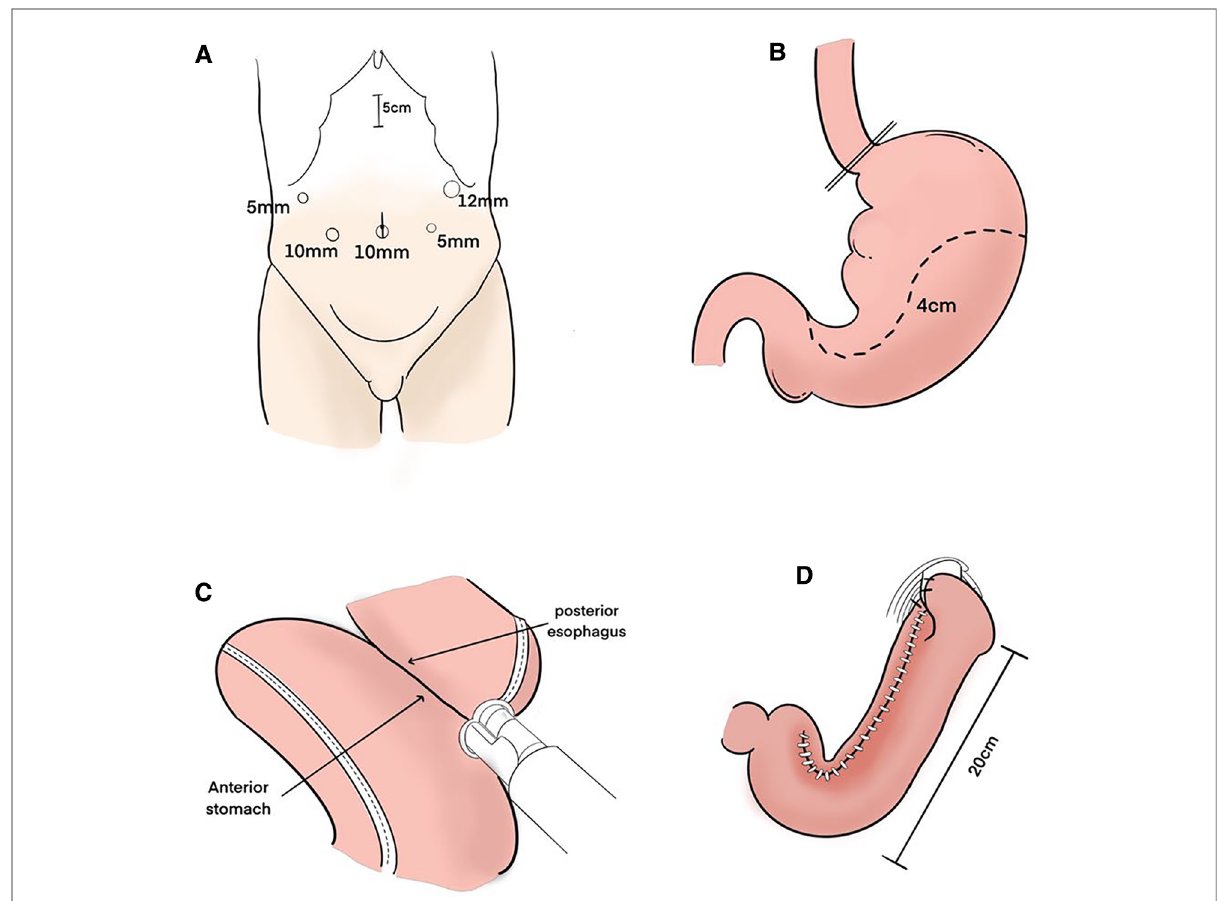
FIGURE 1 Surgical procedure. ( A ) Trocar sites. ( B ) After the esophagus was transected, the upper part of the stomach was excised along a dashed line to create a gastric tube. Its width is about 4 cm. ( C ) The anterior wall of the gastric tube and the posterior wall of the esophagus were anastomosed with linear stapler. ( D ) After anastomosis was performed, the entry hole was closed with barbed suture. The gastric tube was anchored with the right and left crus of the diaphragm by one stitch each to prevent hiatus hernia. The length of the whole gastric tube on the greater curvature side is about 20